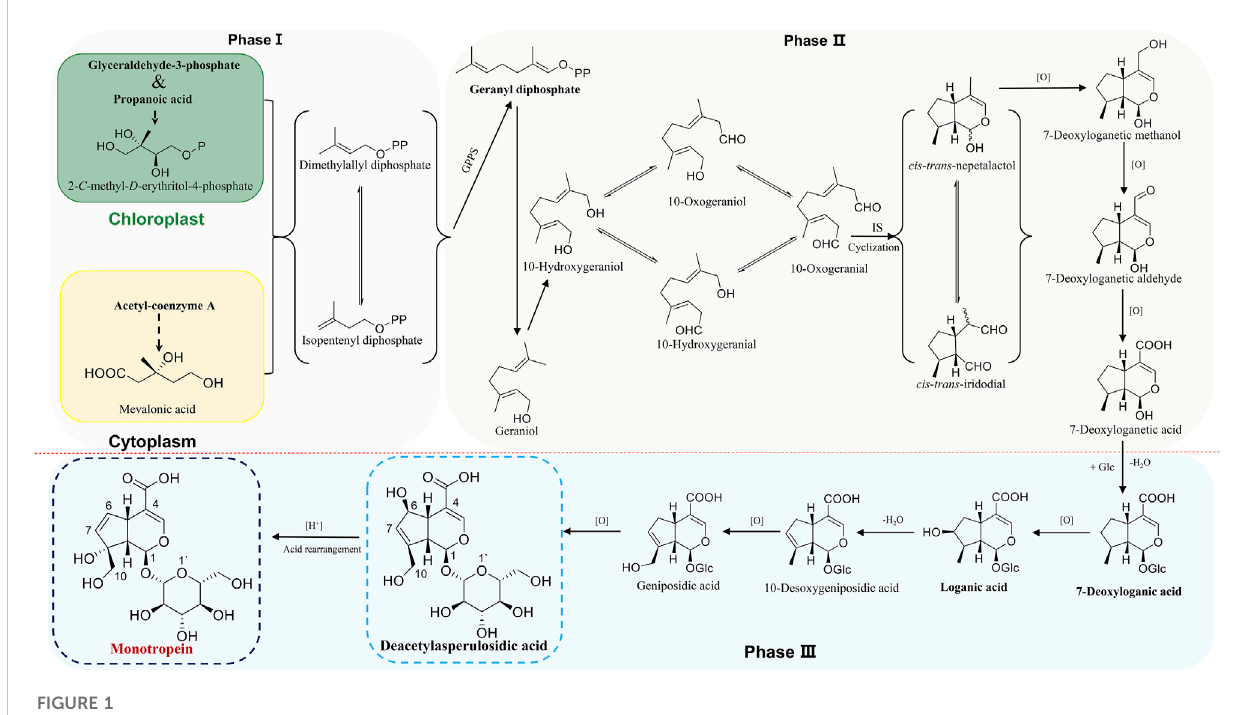
FIGURE 1 The proposed biosynthesis of